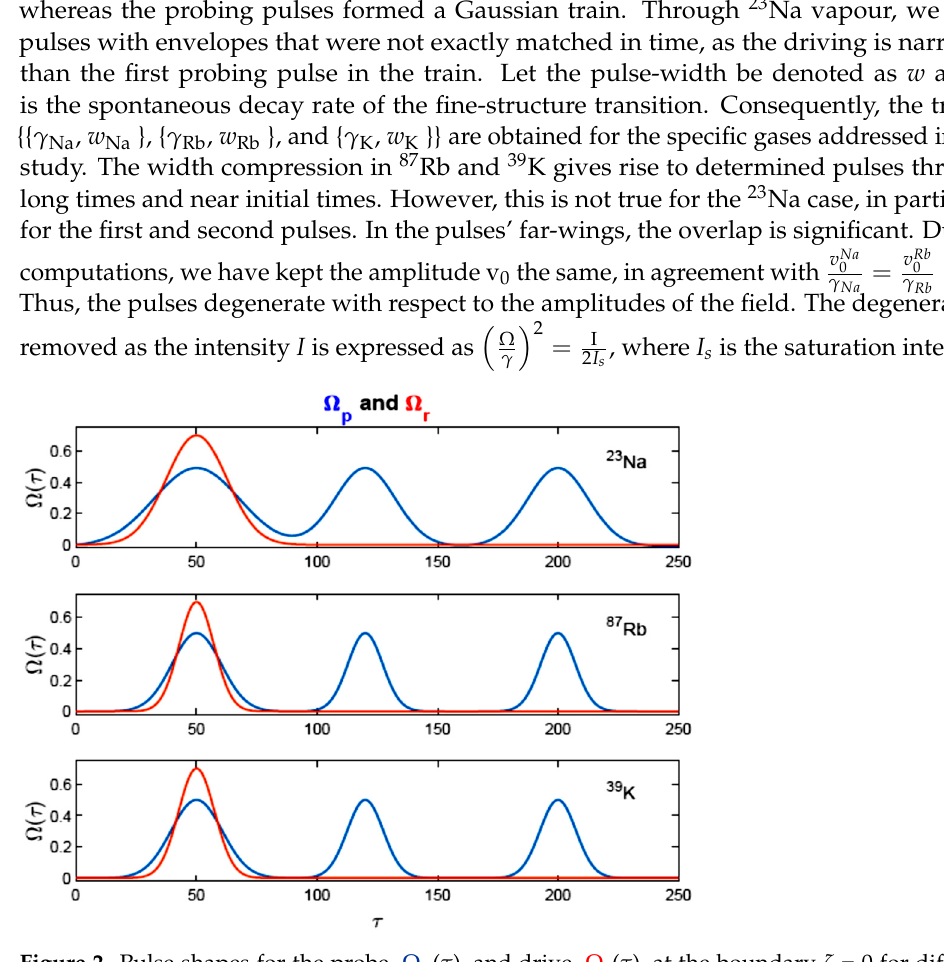
Figure 2. Pulse shapes for the probe, Ω p ( τ ), and drive, Ω r ( τ ), at the boundary ζ = 0 for different vapours. Relative units are adopted for the time, Rabi frequencies, and detuning.